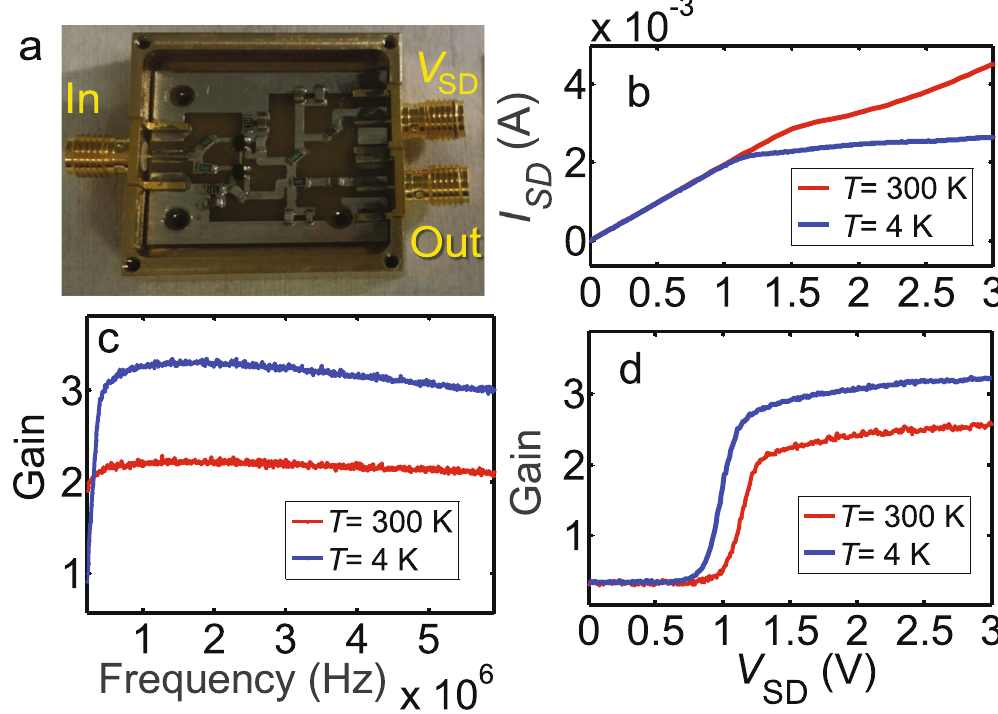
Figure 6. Cryogenic HEMT amplifier. (a) Inside view of the cryoamplifier with a pair of ATF-34143 HEMT transistors. (b) Source-drain current I SD and (d) gain as a function of the supply voltage V SD at two different temperatures T = 4.2 K (blue solid line) and T = 300 K (red solid line) at 3 MHz. By decreasing the temperature, I SD decreases while the gain increases. (c) Frequency dependence of the gain at V SD = 2 V at two different